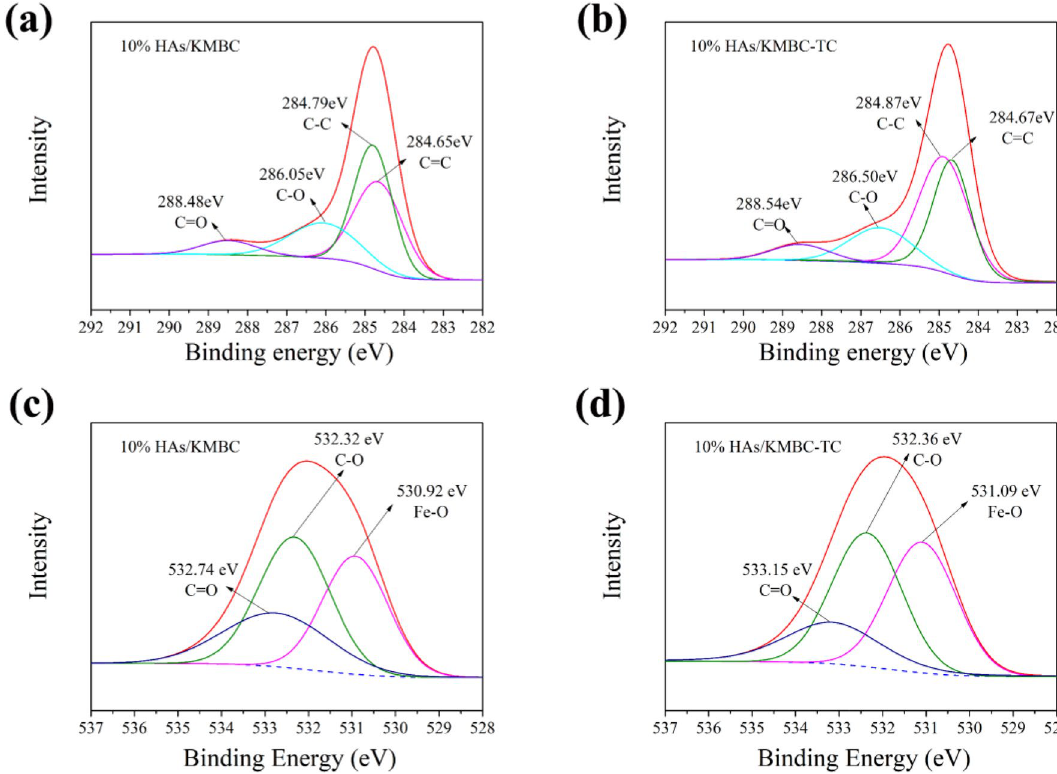
Figure 8. ( a ) and ( b ) are the computer deconvolution C 1 s spectra of 10% HAs/KMBC and 10% HAs/ KMBC-TC, respectively; ( c ) and ( d ) are the computer deconvolution O 1 s spectra of 10% HAs/KMBC and 10% HAs/KMBC-TC,